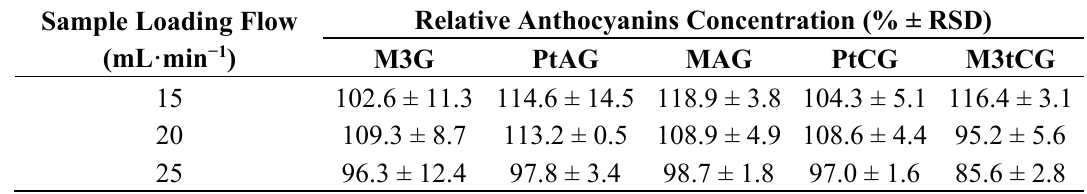
Table 2. Effect of sample loading flow on the recovery of anthocyanins ( n =